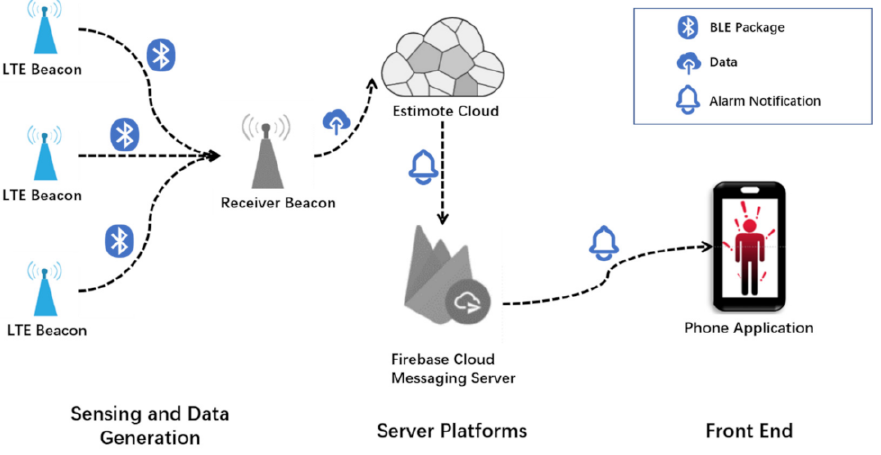
Figure 2. The structure of the